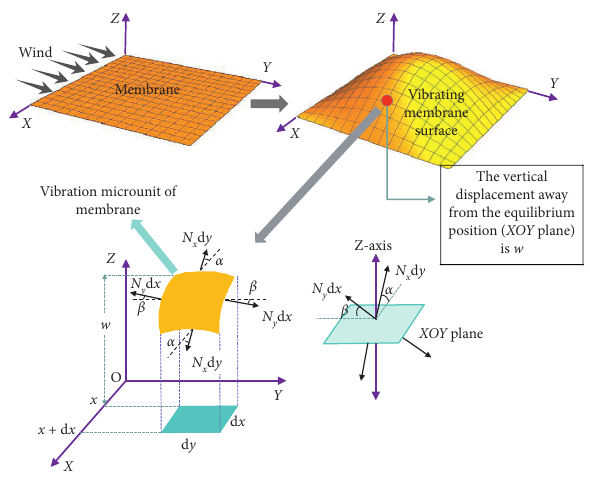
Figure 1: Vibration microunits of